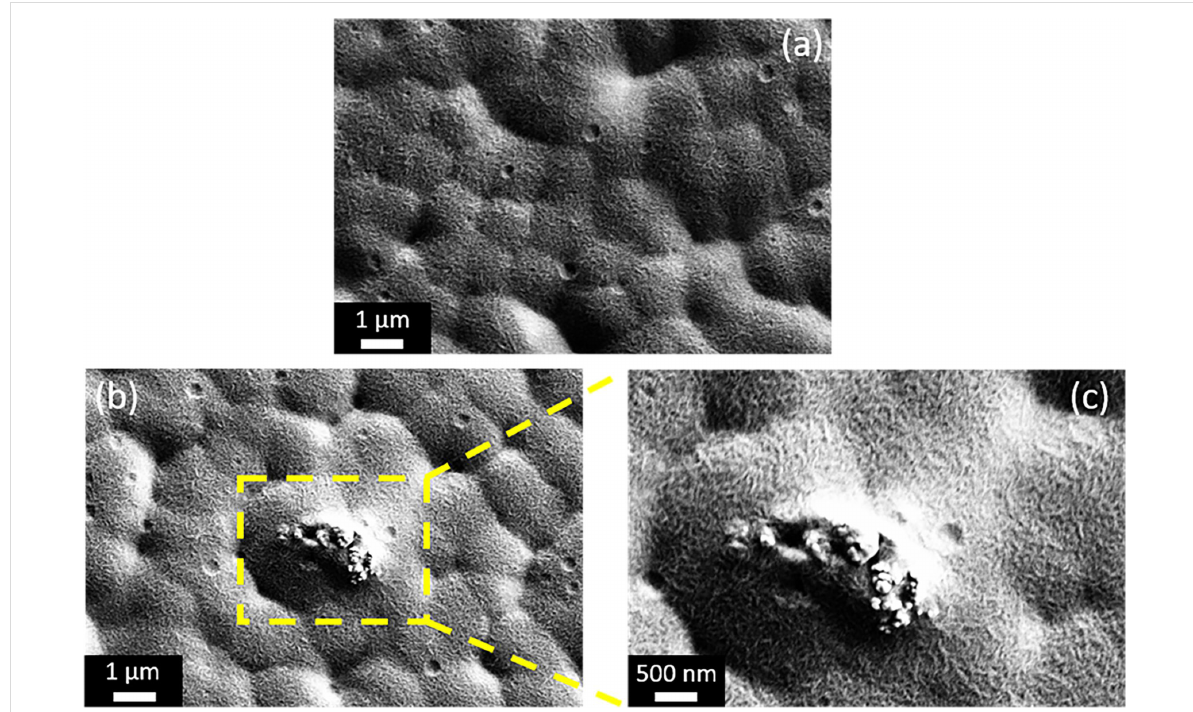
Figure 6: FESEM images of PVDF-TrFe/CoFe 2 O 4 nanocomposites with 5 wt % of CoFe 2 O 4 magnetically poled at 111 mT for 1 h at 65 °C.